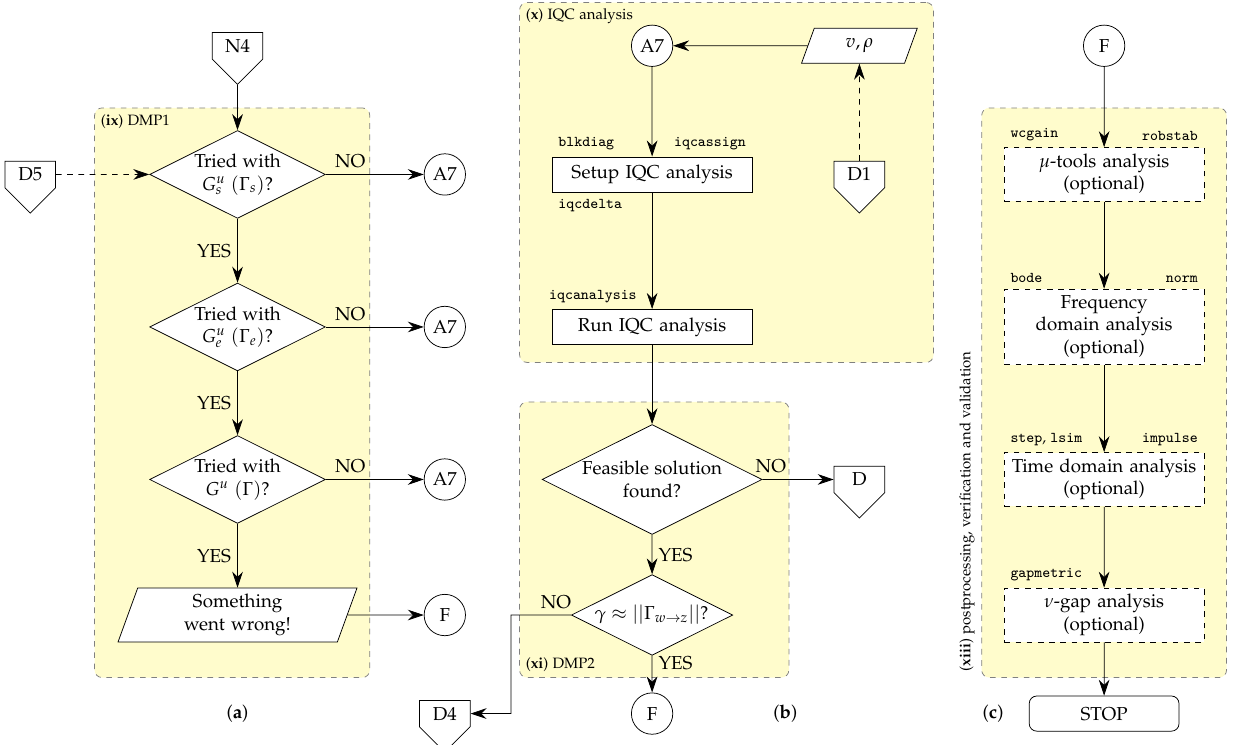
Figure 6. Carry out IQC analysis and optional postprocessing (if the IQC analysis was successful) for a given nominal parts of uncertain system(s) Γ s ( Γ e , Γ ) and check if all the robustness criteria are satisfied. ( a ) Decision making process 1 (DMP1)-if a feasible solution cannot be found and/or performance criterion cannot be met with a Γ s , try Γ e or Γ . ( b ) IQC analysis process and decision making process 2 (DMP2)-if there is no feasible solution found to the IQC analysis appropriate changes have to be made; either to the IQC analysis parameters or the uncertain system (see Figure 7 for further details), if there was feasible solution found, but the specified performance criterion has not been met, then the discretizations and/or orders of the reduced order models are too low and have to be adjusted. ( c ) Continue to optional post-processing—i.e., carry out robustness analysis using µ -tools instead of IQCs, run ν -gap analysis or perform frequency and/or time domain simulations to confirm the desired behaviour of the obtained uncertain interconnected